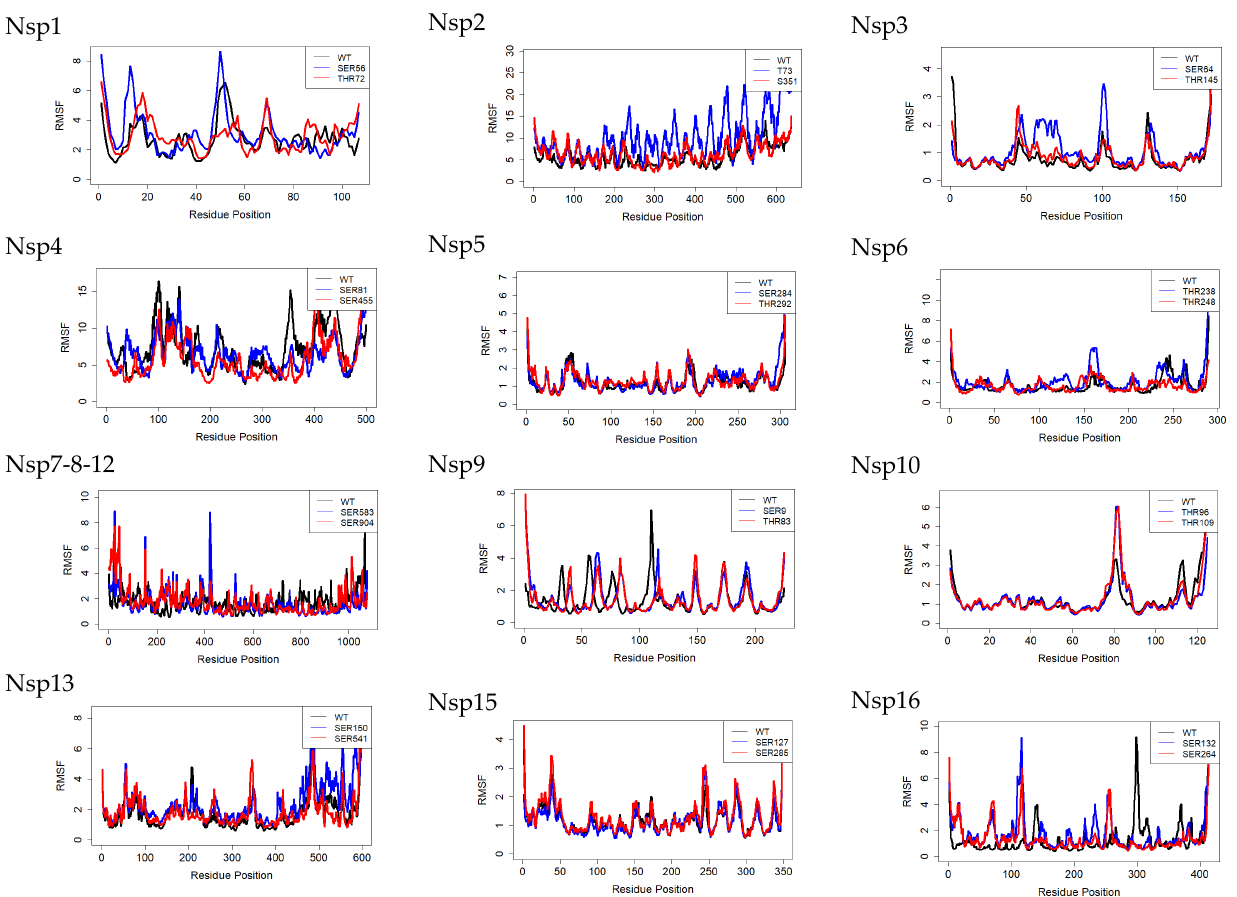
Figure 4. The RMSF measures the mobility of the protein backbone amino acid residues. We calculated RMSF for the 36 MD-simulated structures (12 un-phosphorylated, 12 phosphorylated sites 1, and 12 phosphorylated sites 2) throughout the simulation (100 ns throughout the simulation compared to the starting conformation.